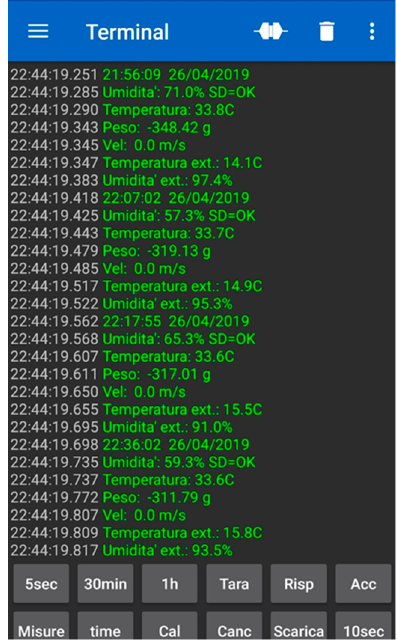
Figure 5. Example of a sheet screenshot with data downloaded from the PAS platform.